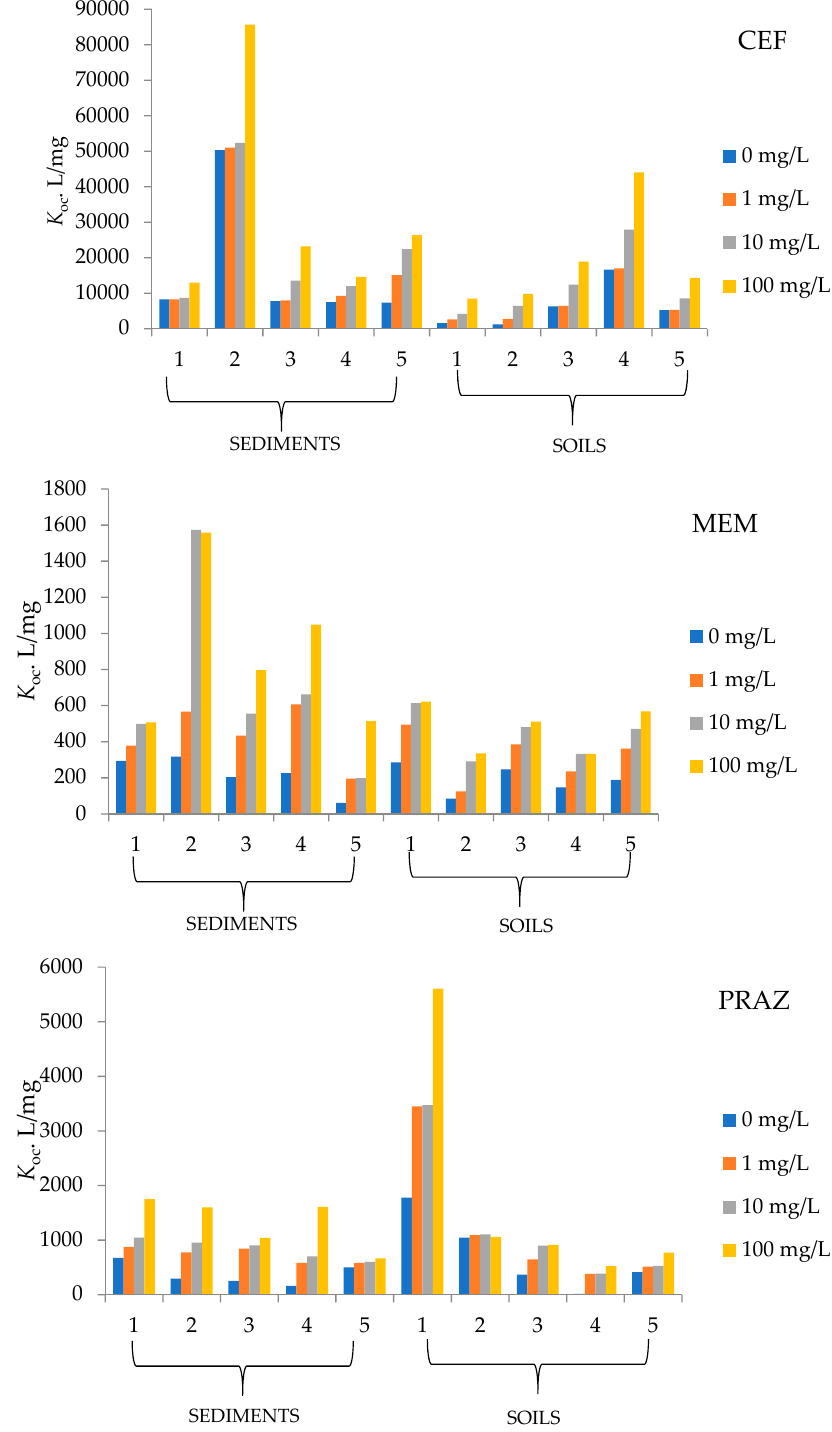
Figure 2. Soil and sediment sorption coefficients for tested pharmaceuticals.